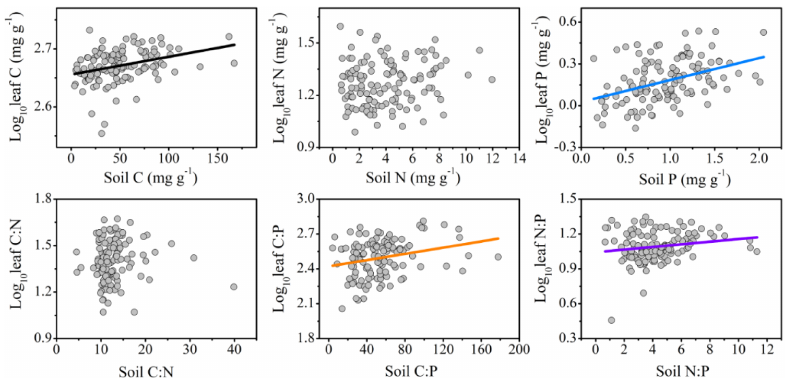
Figure B6. Variation trends of leaf C:N:P stoichiometry as a function of soil C:N:P. Data points indicate every observation of shrub stoichiometry within the sampling sites ( n = 125). Lines are plotted if regressions were significant at P < 0.05. Leaf element concentrations and ratios were log 10 -transformed before